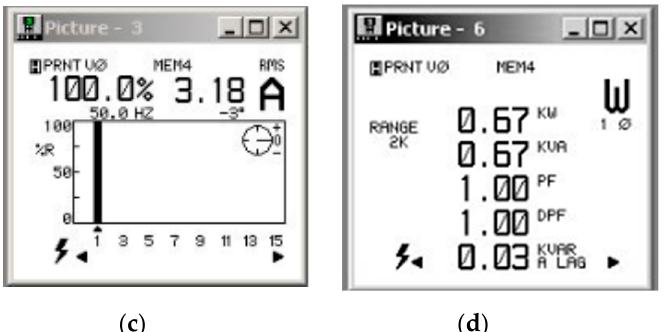
Figure 23. Experimental results for the adaptive control at reduced load on the supply side after compensation, in steady state regime, provided by Fluke 41B analyzer: ( a ) waveform of the supply current; ( b ) RMS value and supply current THD ; ( c ) harmonic spectrum of the supply current; ( d ) powers per phase and power factor.